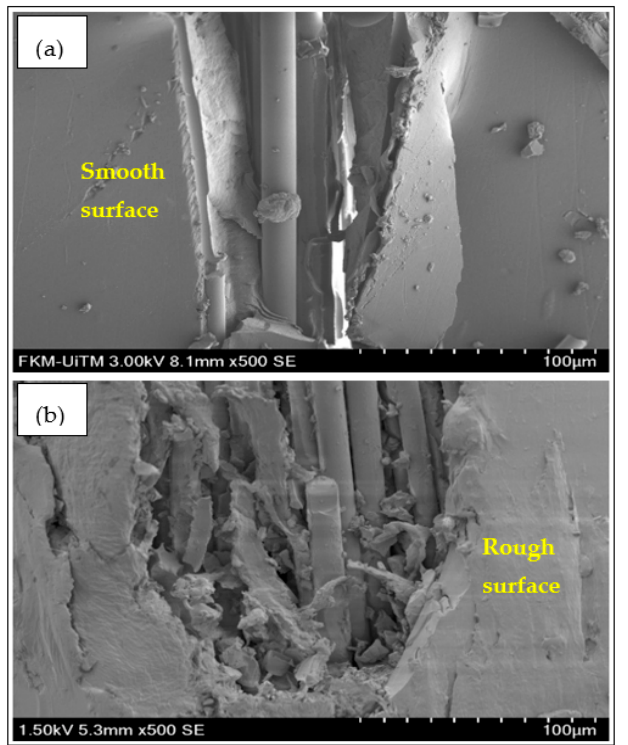
Figure 10. SEM micrographs of fractured unmodified BFRP composites of ( a ) unconditioned and ( b ) conditioned specimen.